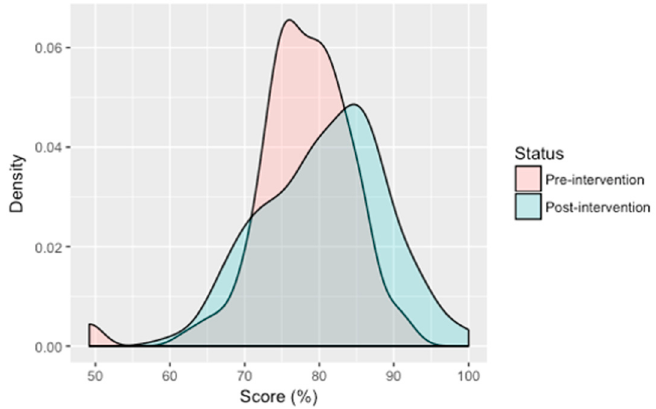
Figure 5. Density plot of pre- and post-intervention behaviour scores.